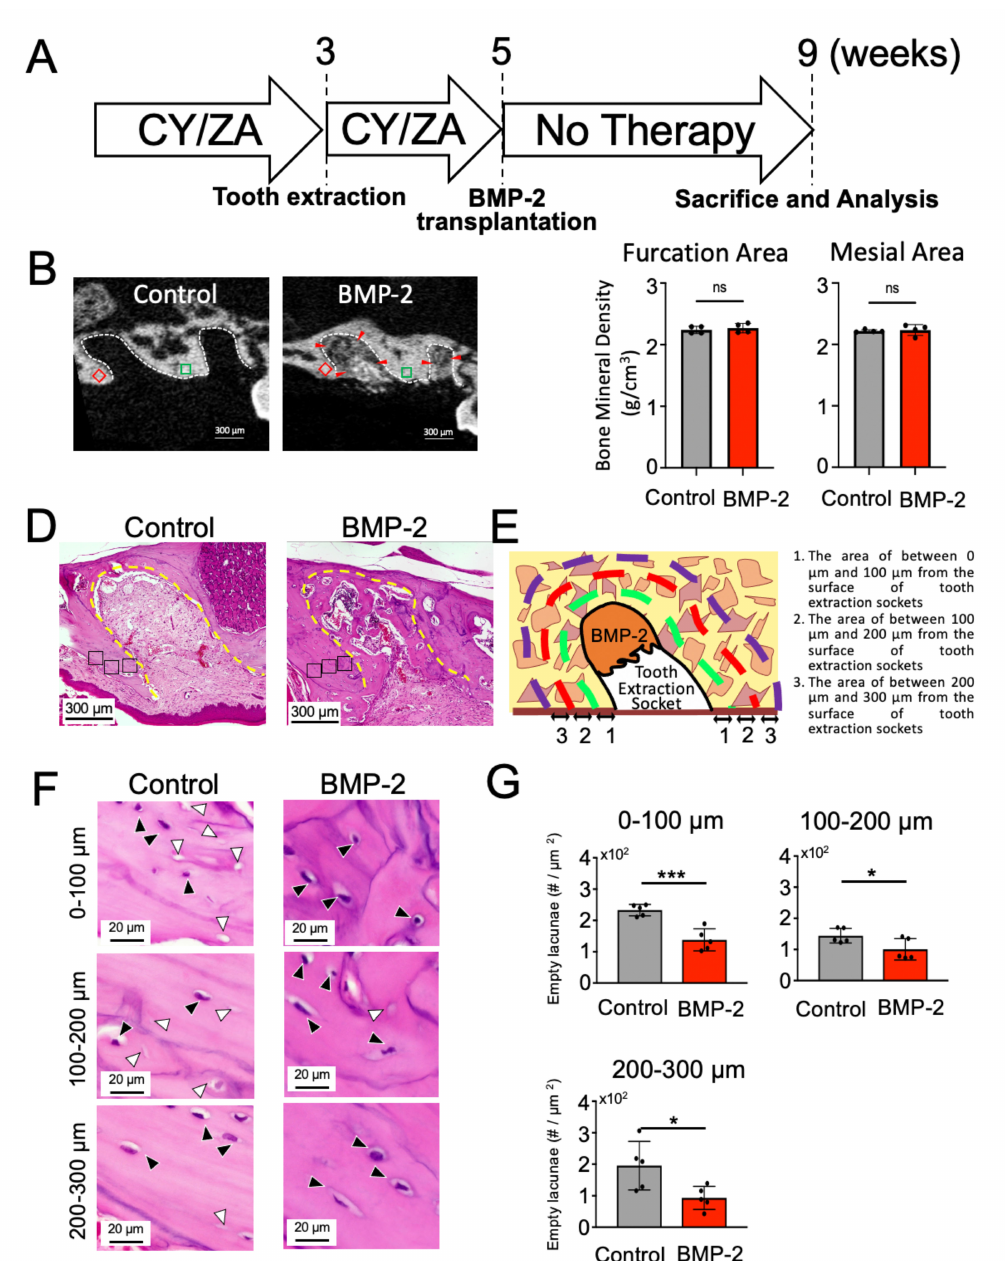
Figure 4. Effect of BMP-2/ β -TCP on the bone surrounding the tooth extraction socket in the MRONJ- like treatment model. ( A ) Experimental design: Extraction of the maxillary first molar of mice was performed after three weeks of CY/ZA administration. Two weeks after extraction, BMP2/ β -TCP